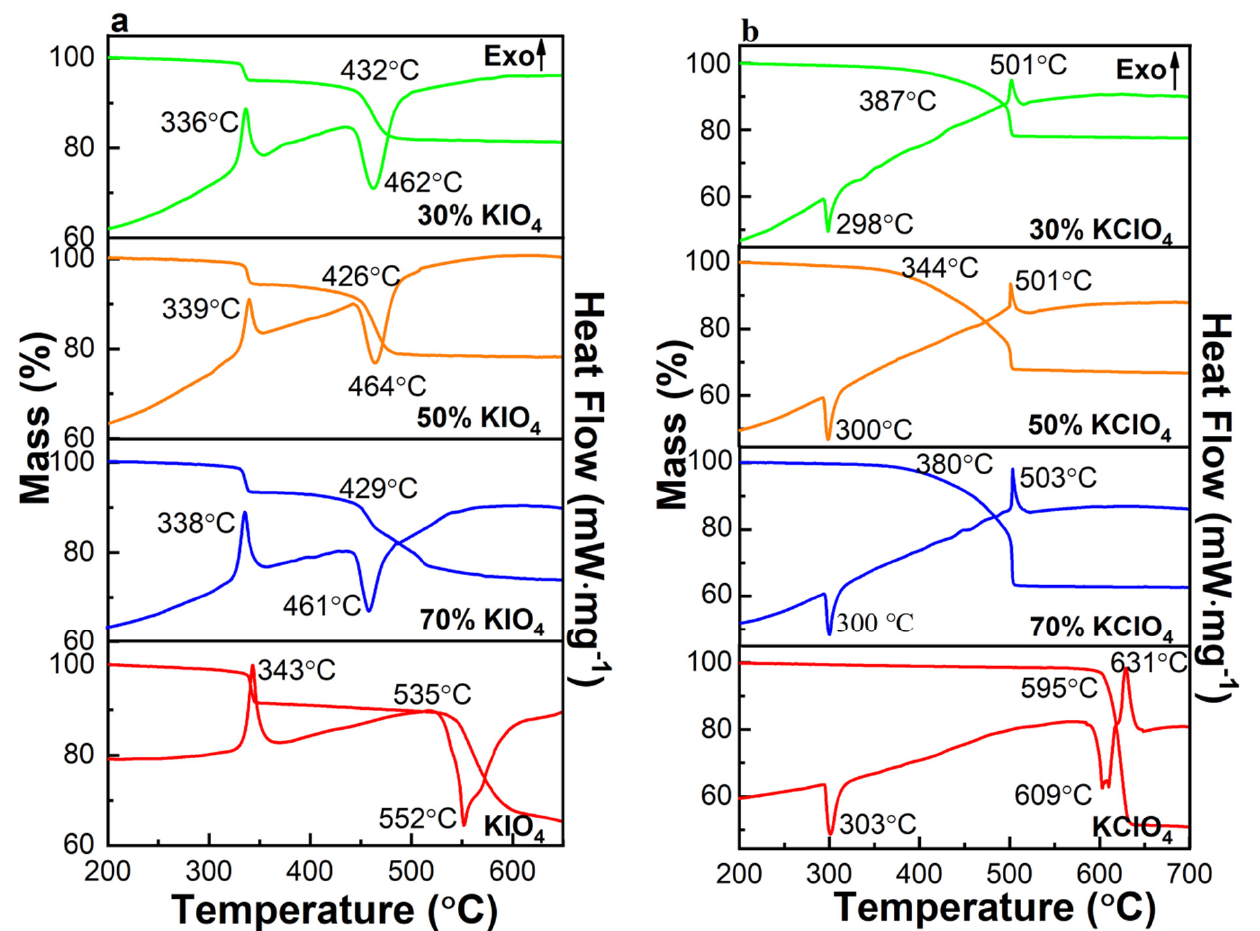
Figure 4. DSC and TG curves of ( a ) CuO/xKIO 4 and ( b ) CuO/xKClO 4